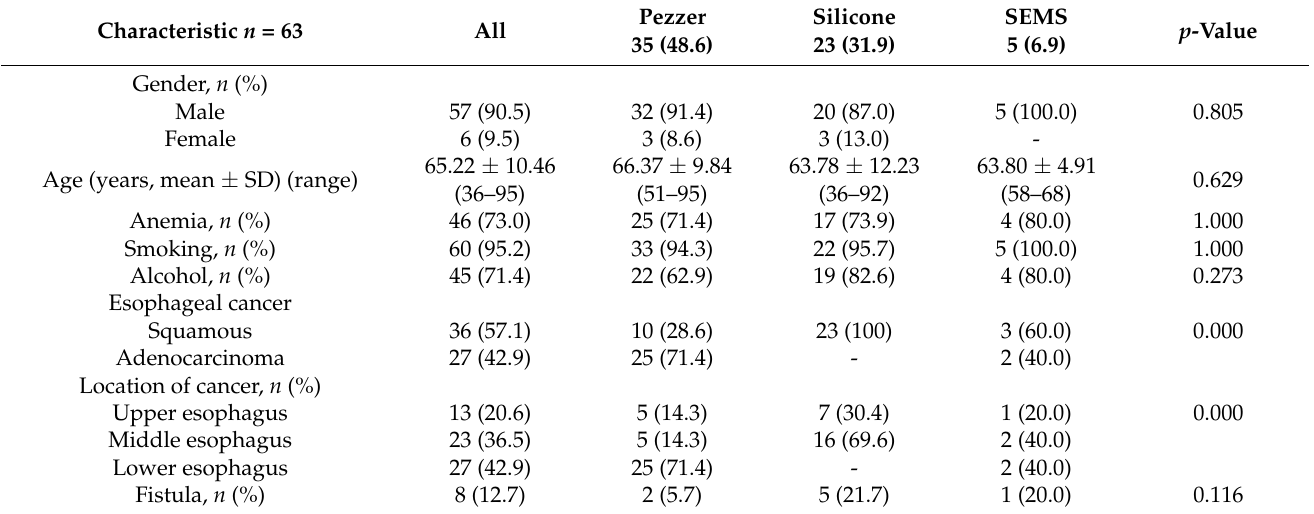
Table 1. Characteristics of study